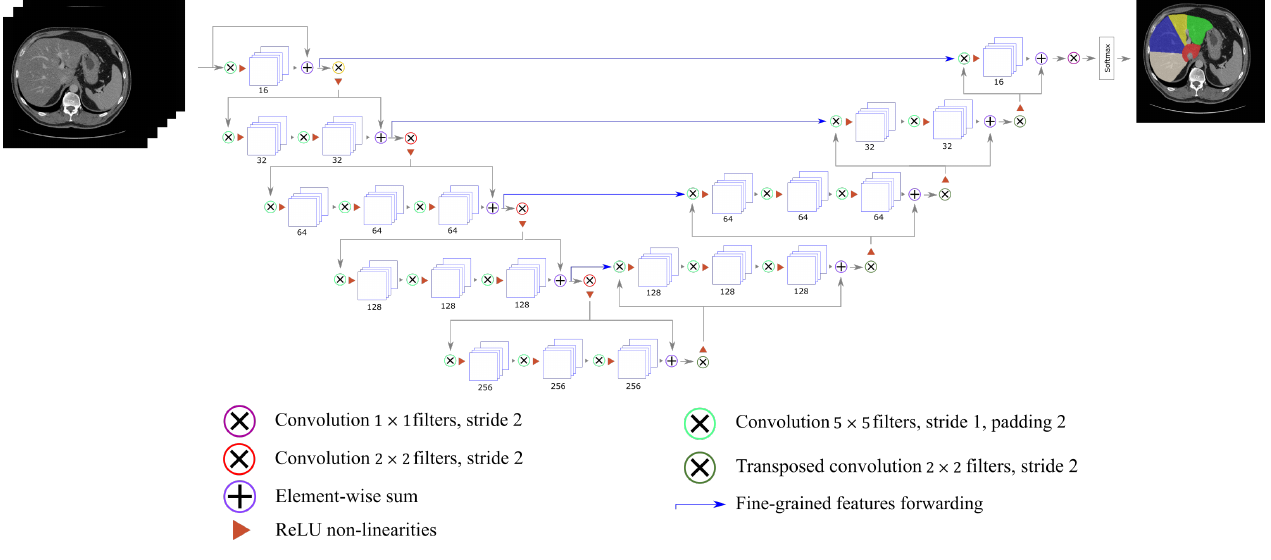
Figure 2. V-Net for multi-class segments’